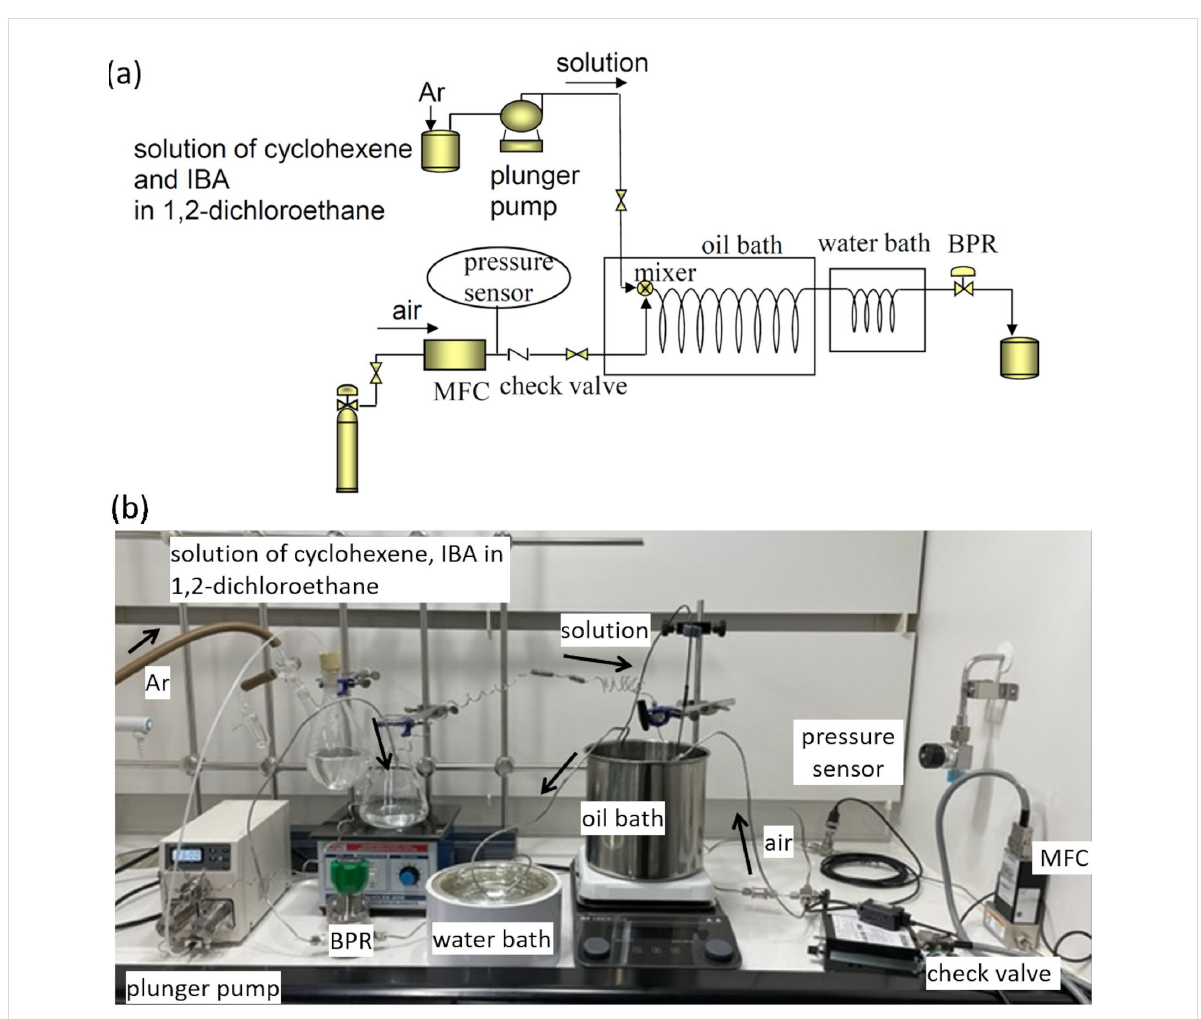
Figure 2: Schematic diagram (a) and photo (b) of the flow reactor used for cyclohexene epoxidation with air. IBA = isobutyraldehyde.